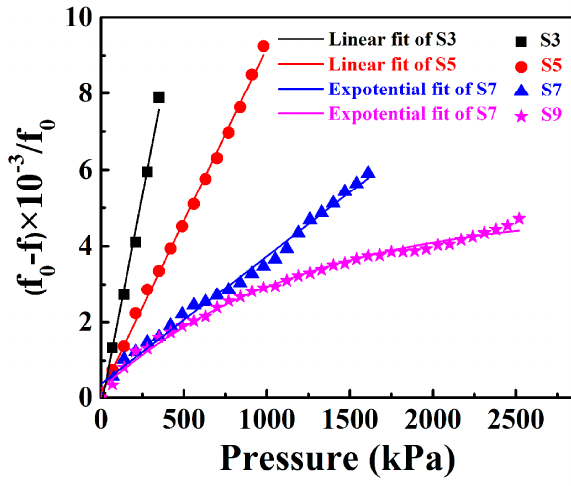
Figure 8. Frequency responses of the four different pressure sensors as a function of pressure.